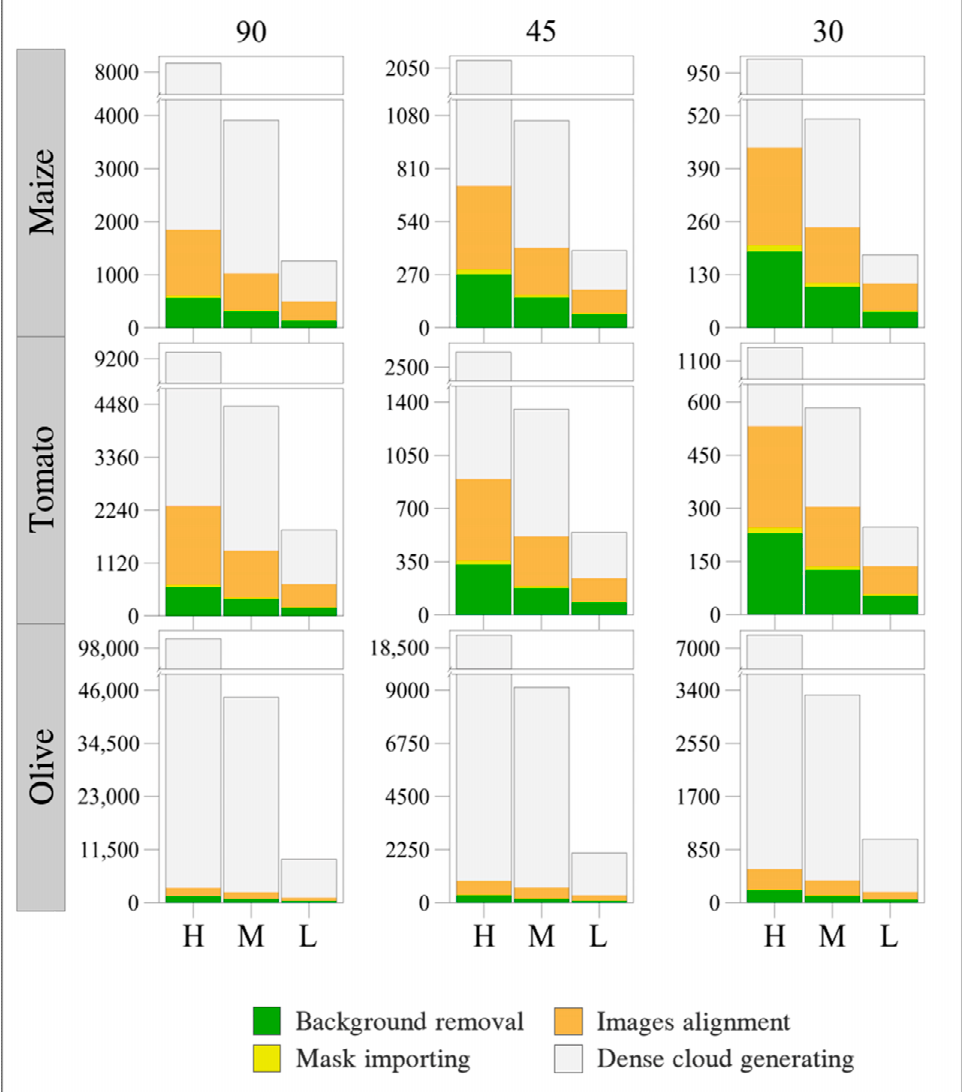
Figure 4. Average time, in seconds (sec), required for each main step (background removal, mask importing, images alignment and dense cloud generating) of image processing for the three-dimensional (3D) reconstruction of maize, tomato and olive-tree plants considering every combination of photo quantity (90, 45, 30) and quality (H, M, L).